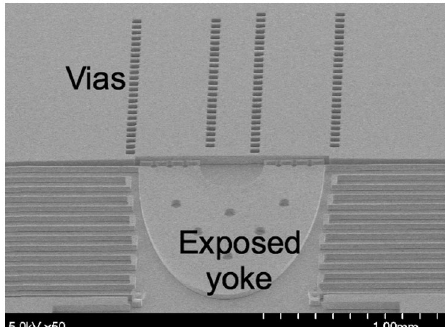
FIG. 13. Scanning electron micrograph taken at 45 (cid:8) showing a MEMS microactuator during fabrication demonstrating results of the via process step.